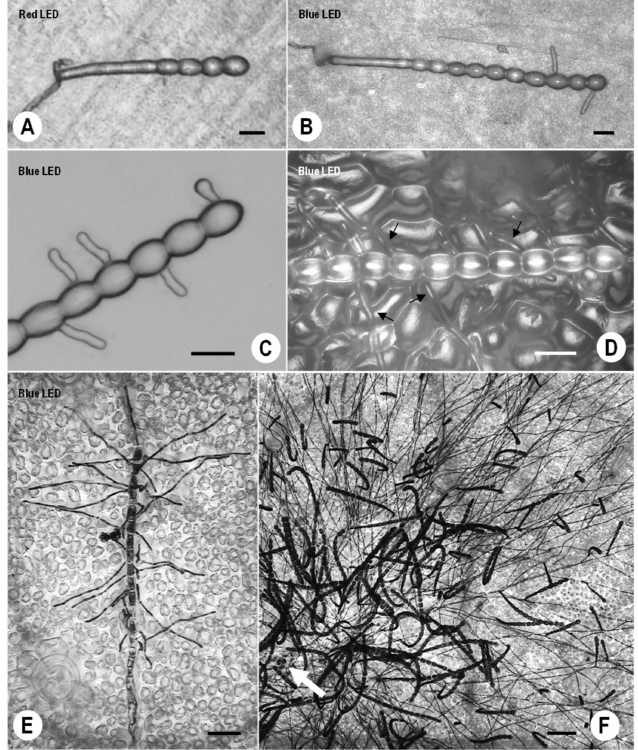
Figure 3. Comparison of conidial germination and fungal development between KMP-6N conidio- phores under red ( A ) and blue LED irradiation ( B – F ). ( A – D ) Digital micrographs of conidiophores irradiated under red ( A ) or blue light ( B ) and then inoculated onto parafilm. Conidiophores